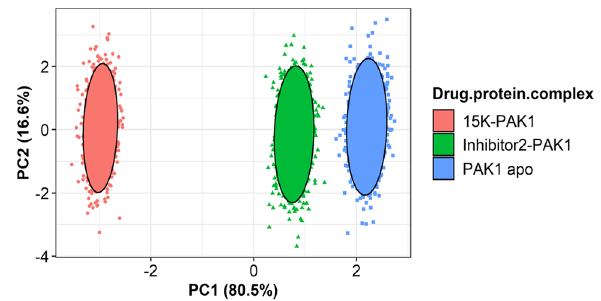
Figure 8. PCA analysis on MD simulation. The score plot displays three clusters, where each dot indicates one time point. The clustering is attributable to: 15K-PAK1 (Red), inhibitor 2-PAK1 (Green), and apo-PAK1 (Blue).